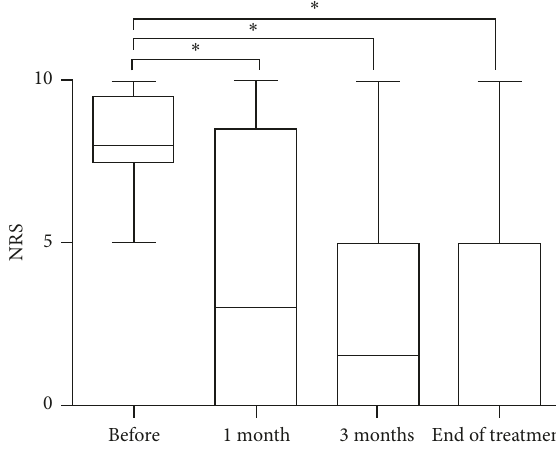
Figure 3: The pain intensity in each visiting time at pain center. Horizontal bar represents medians, boxes represent the 25th and 75th percentile ranges, and T bars represent the 5th and 95th percentile ranges. ∗ Difference between before and after treatment ( P < 0 . 01) (Wilcoxon test).